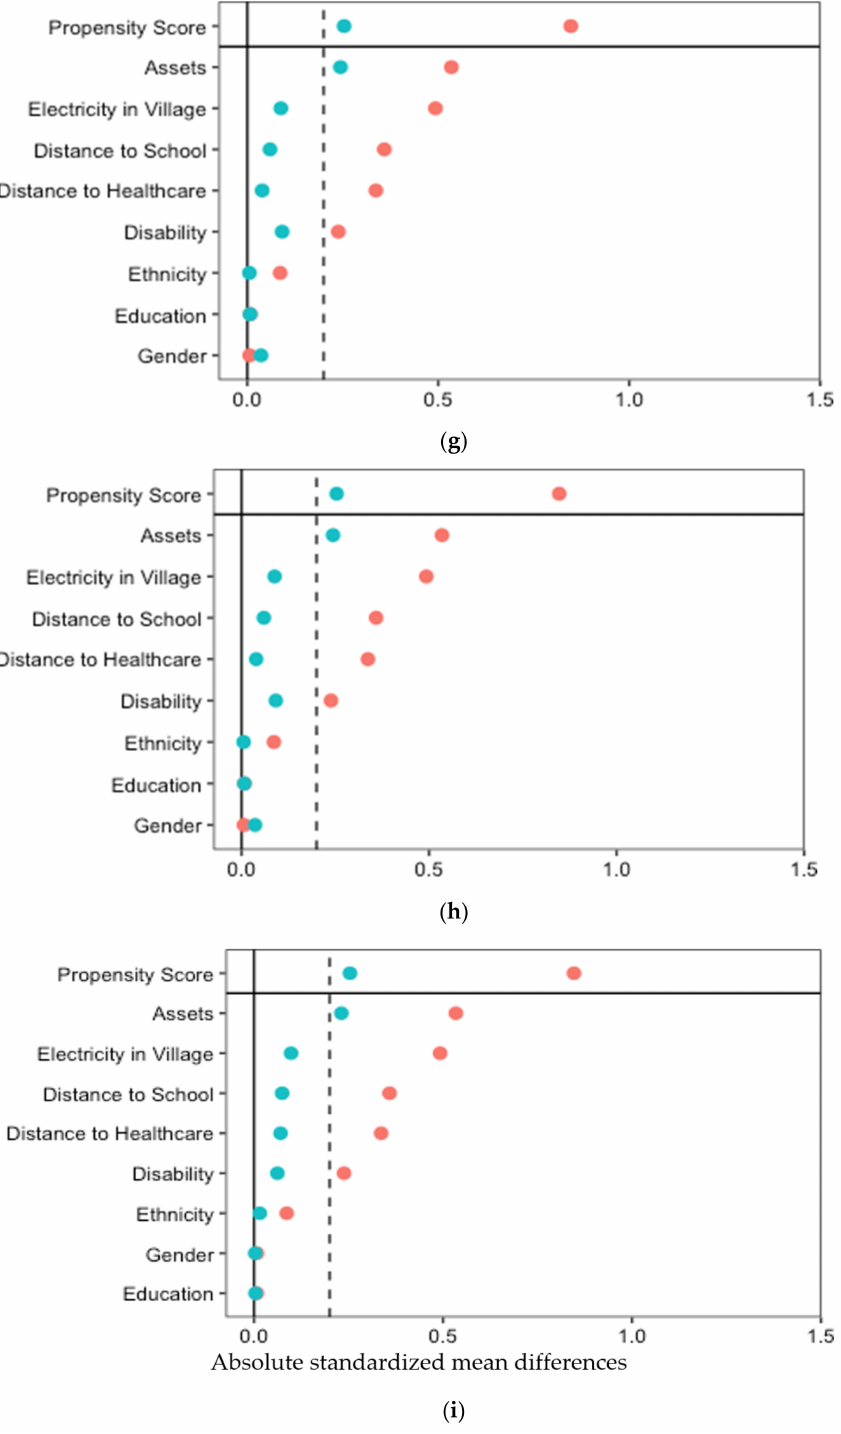
Figure 3. Balance results of the propensity-score matching for the sample for unmet needs. Model